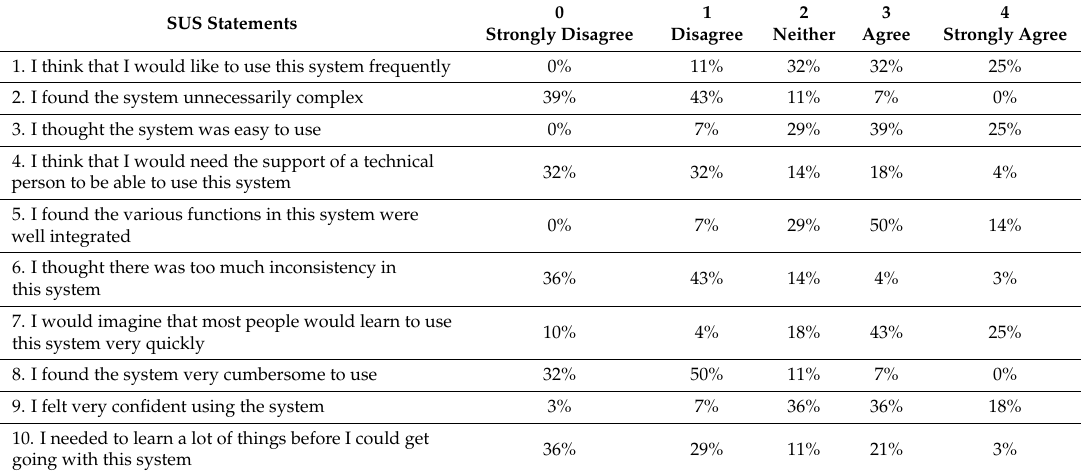
Table 2. The list of phrases according to SUS method.